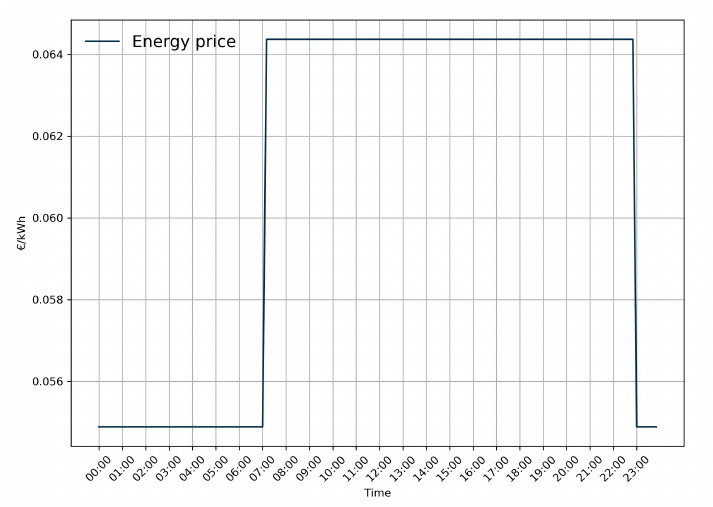
Figure 11. This figure shows how the price of energy varies over the course of a